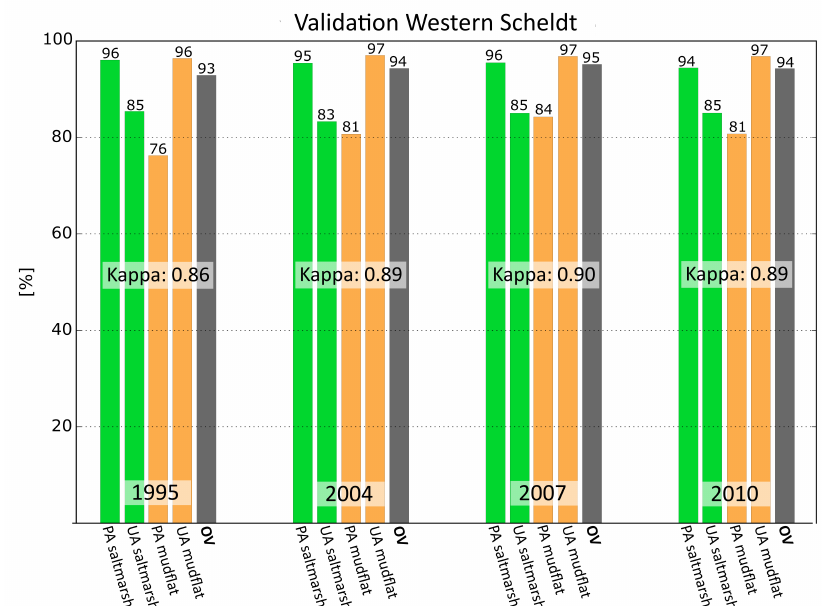
Figure 3. Validation results for the Western Scheldt 1995, 2004, 2007 and 2010. Calculated producer accuracy (PA), user accuracy (UA), for the classes saltmarsh and mudflat, and overall accuracy (OA), and the Kappa coefficient (Kappa) for the saltmarsh–mudflat–water classification are